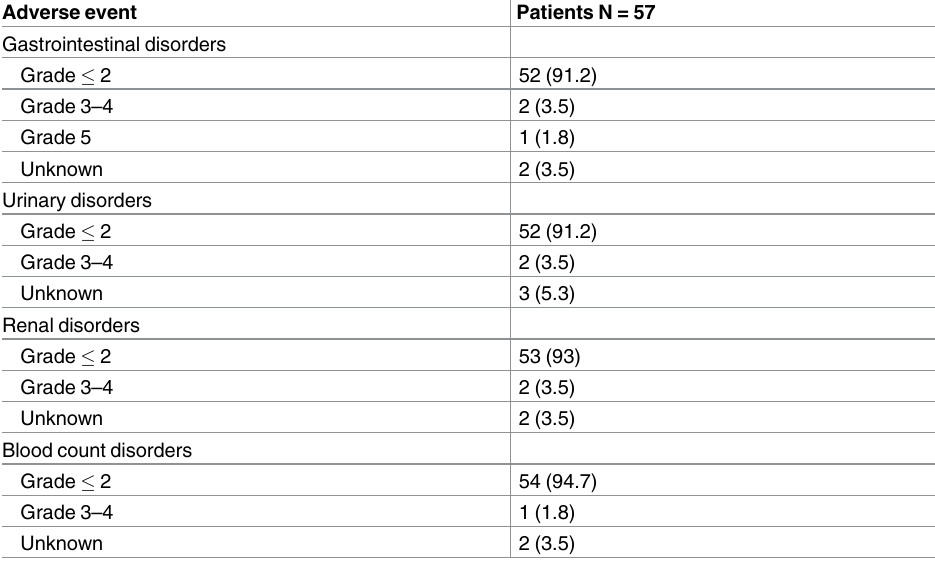
Table 4. Acute toxicities of adjuvant